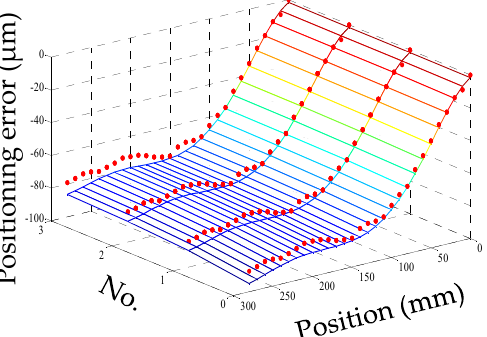
Figure 17. The prediction results of the PCR model (measured positioning error marked with dots) in experiment II.